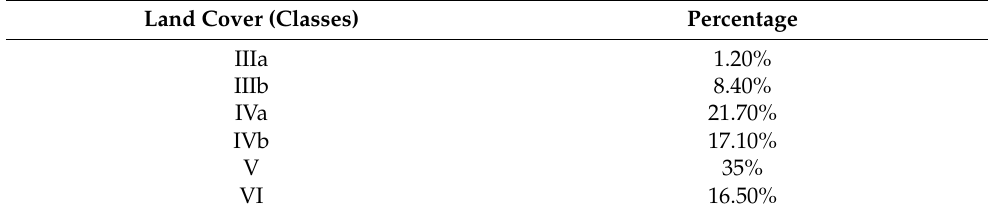
Table 8. Percentage share of the different soil quality classes in the total area of arable land in the municipality of Kleszcz ó